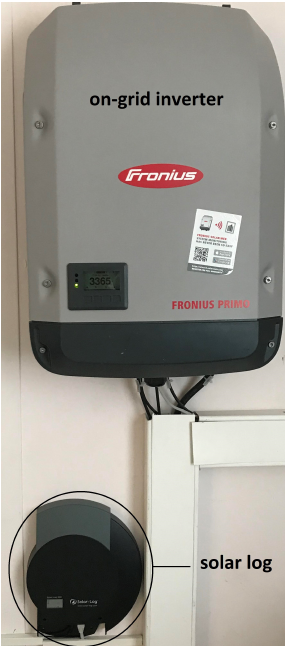
Figure 4. On-grid inverter with solar